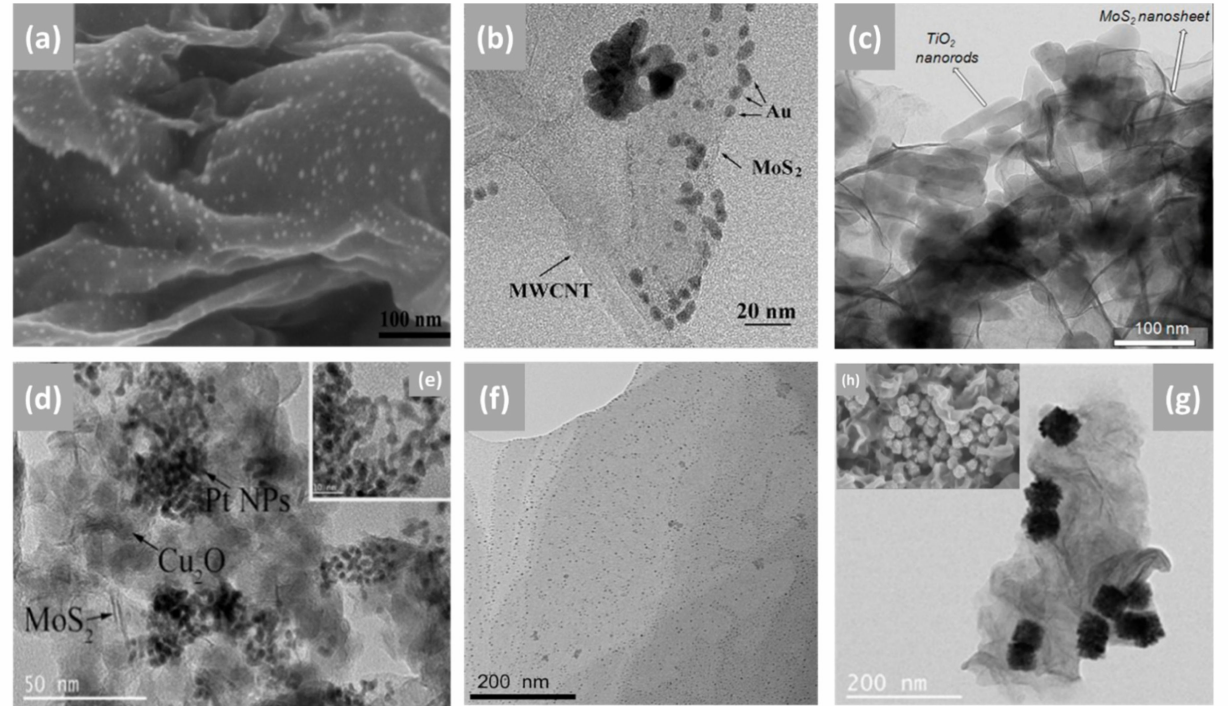
Figure 3. SEM image of ( a ) MoS 2 -Au [13], TEM images of ( b ) MoS 2 -MWCNT/Au [83], ( c ) MoS 2 - TiO 2 [106], ( d ) MoS 2 -Cu 2 O/Pt, (( e ) insert Pt NPs) [70], ( f ) N/F/MoS 2 -Ag [88], and ( g ) MoS 2 -PtPd (( h ) insert SEM of MoS 2 -PtPd) [96], produced by in situ functionalization. Figures reproduced